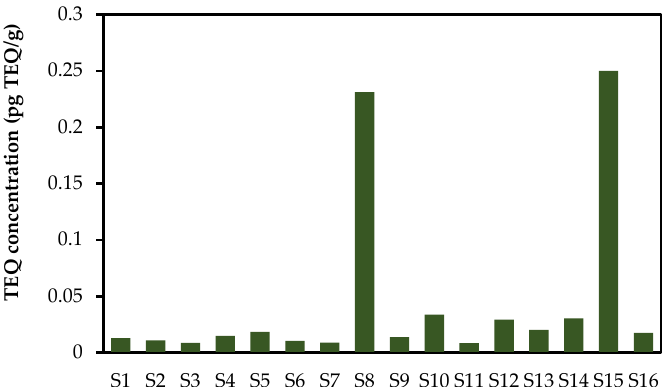
Figure 4. TEQ concentrations of the sediments in the Yangtze River Basin.